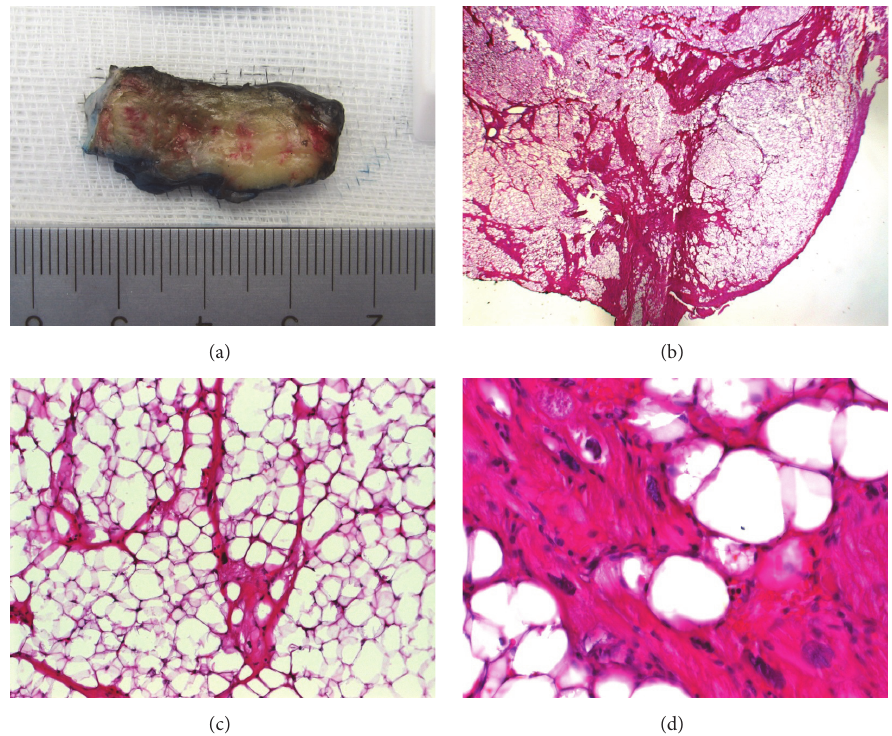
Figure 1: (a) Gross feature of LHIS showed diffuse thickening of the interatrial septum with yellow cut surface. (b) Histological overview showed extensive fat entrapping cardiomyocytes. (c) High power shows mature adipocytes and residual muscle forming septa. (d) High power of myocytes shows enlarged bizarre nuclei mimicking